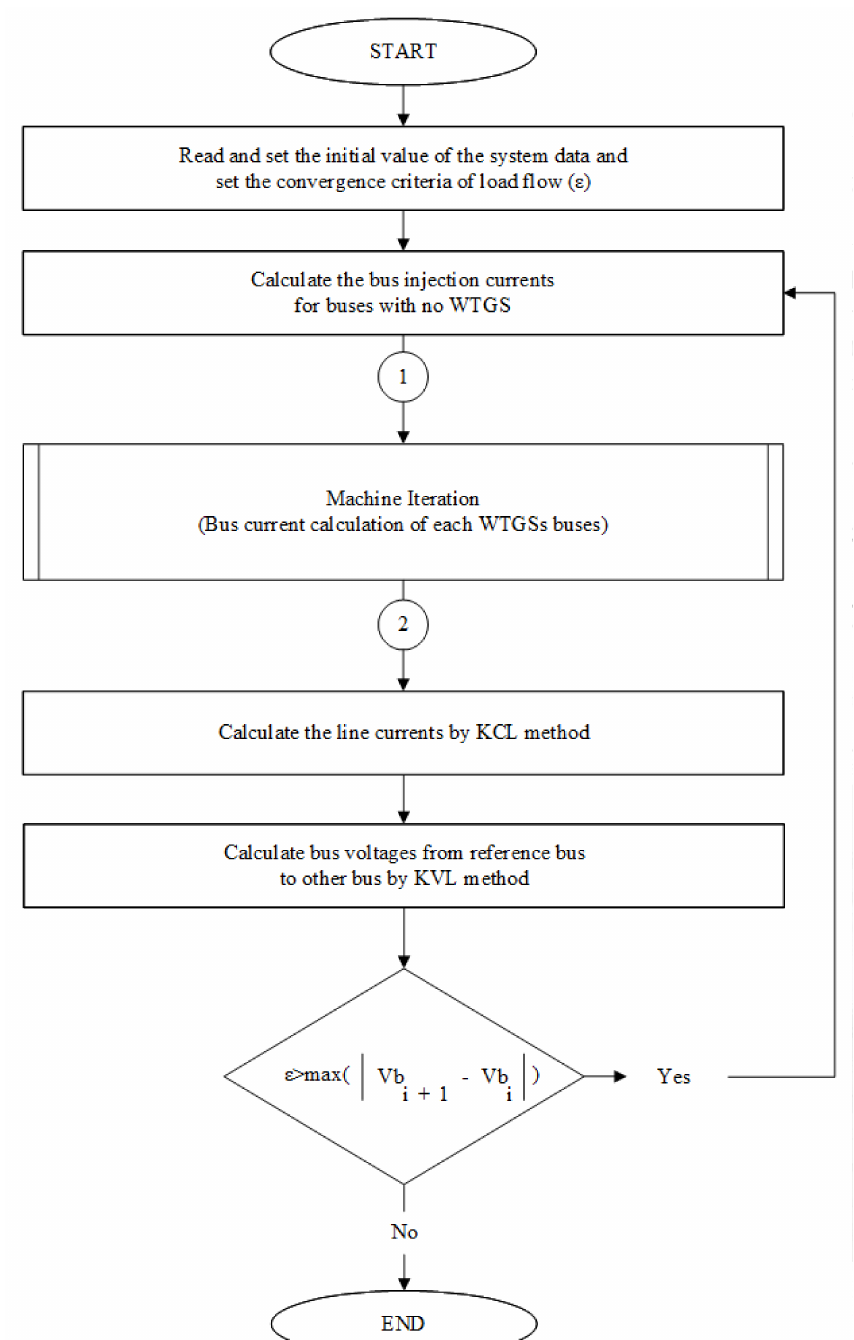
Figure 2. Flowchart of the Load Flow